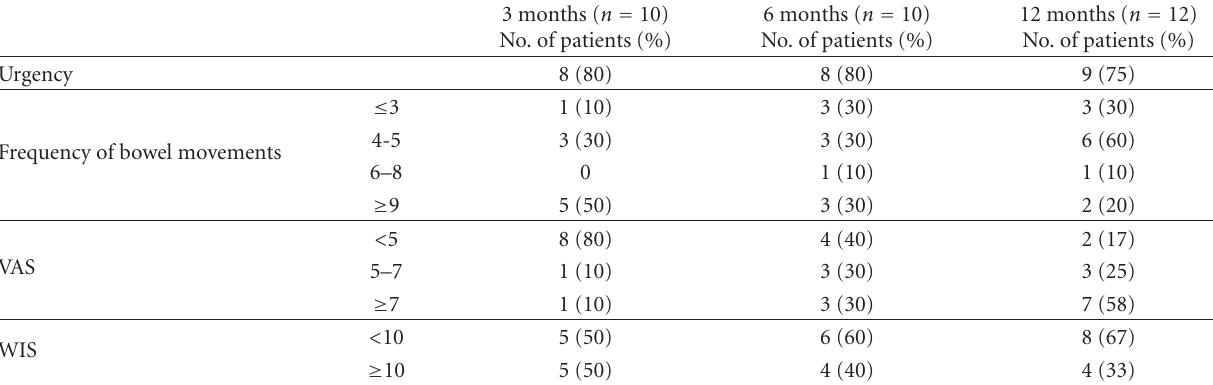
Table 2: Sphincter function after stoma